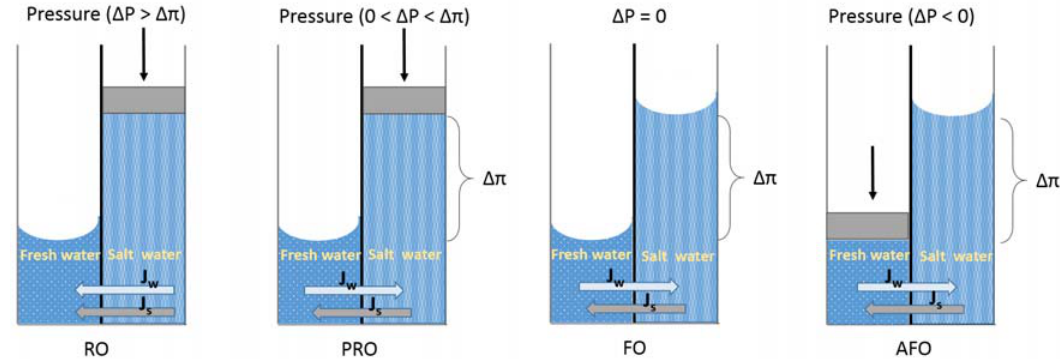
Figure 1. Osmotic processes in membrane filtration. Δ P is applied hydraulic pressure; Δπ is osmotic pressure difference between the two solutions; J